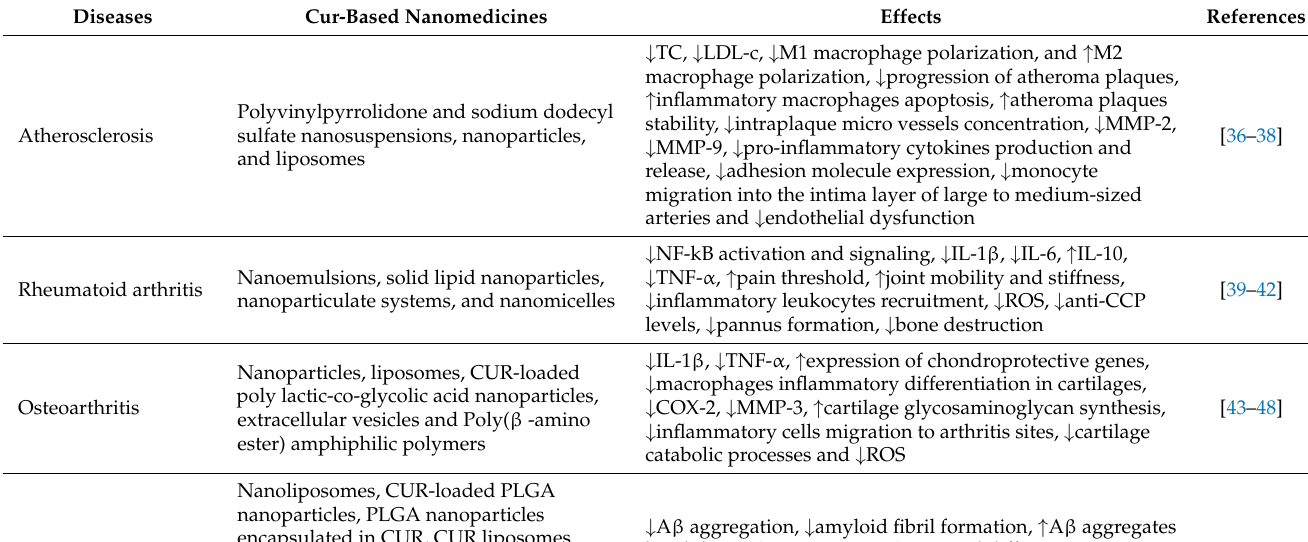
Table 1. Inflammatory and immunomodulated diseases and potential therapeutic effects of CUR- based nanomedicines against these